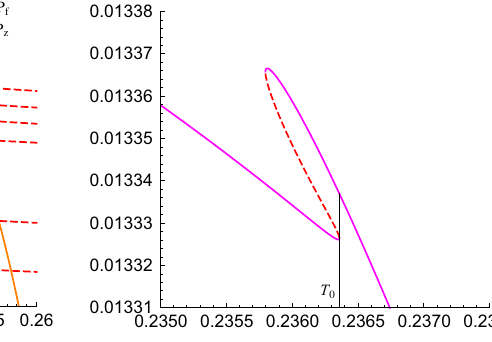
joins of dashed and solid lines, C P diverges. In addition, G − T curves are shifted for clarity. The vertical line at T 1 ∈ ( T t , T z ) ( T 0 ∈ indicates a discontinuity in the Gibbs free energy which shows a zeroth order SBH–IBH (SBH–LBH) phase